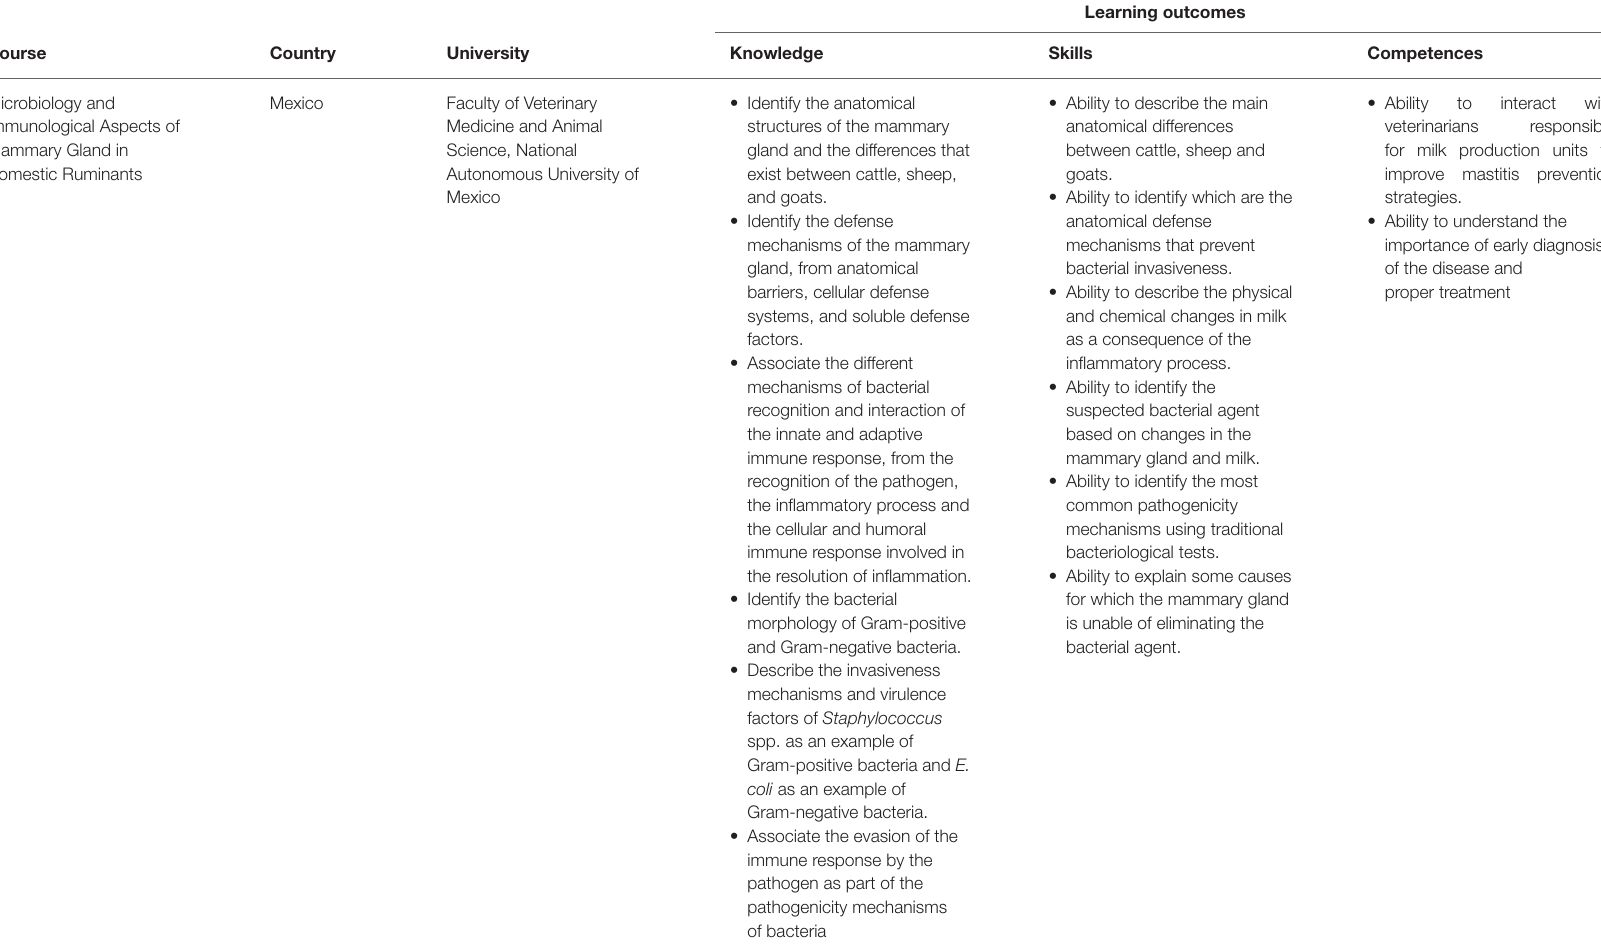
TABLE 1 | Learning outcomes based on knowledge, skills, and competences of the courses Microbiology and Immunological Aspects of Mammary Gland in Domestic Ruminants (Mexico) and Experimental Animal Nutrition and Physiology